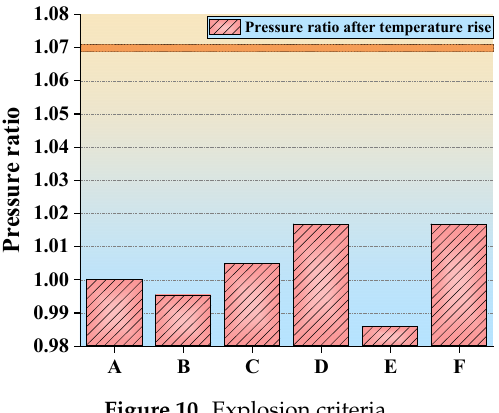
Proportion Figure 10. Explosion Figure 10. Explosion criteria. Figure 10. Explosion criteria.